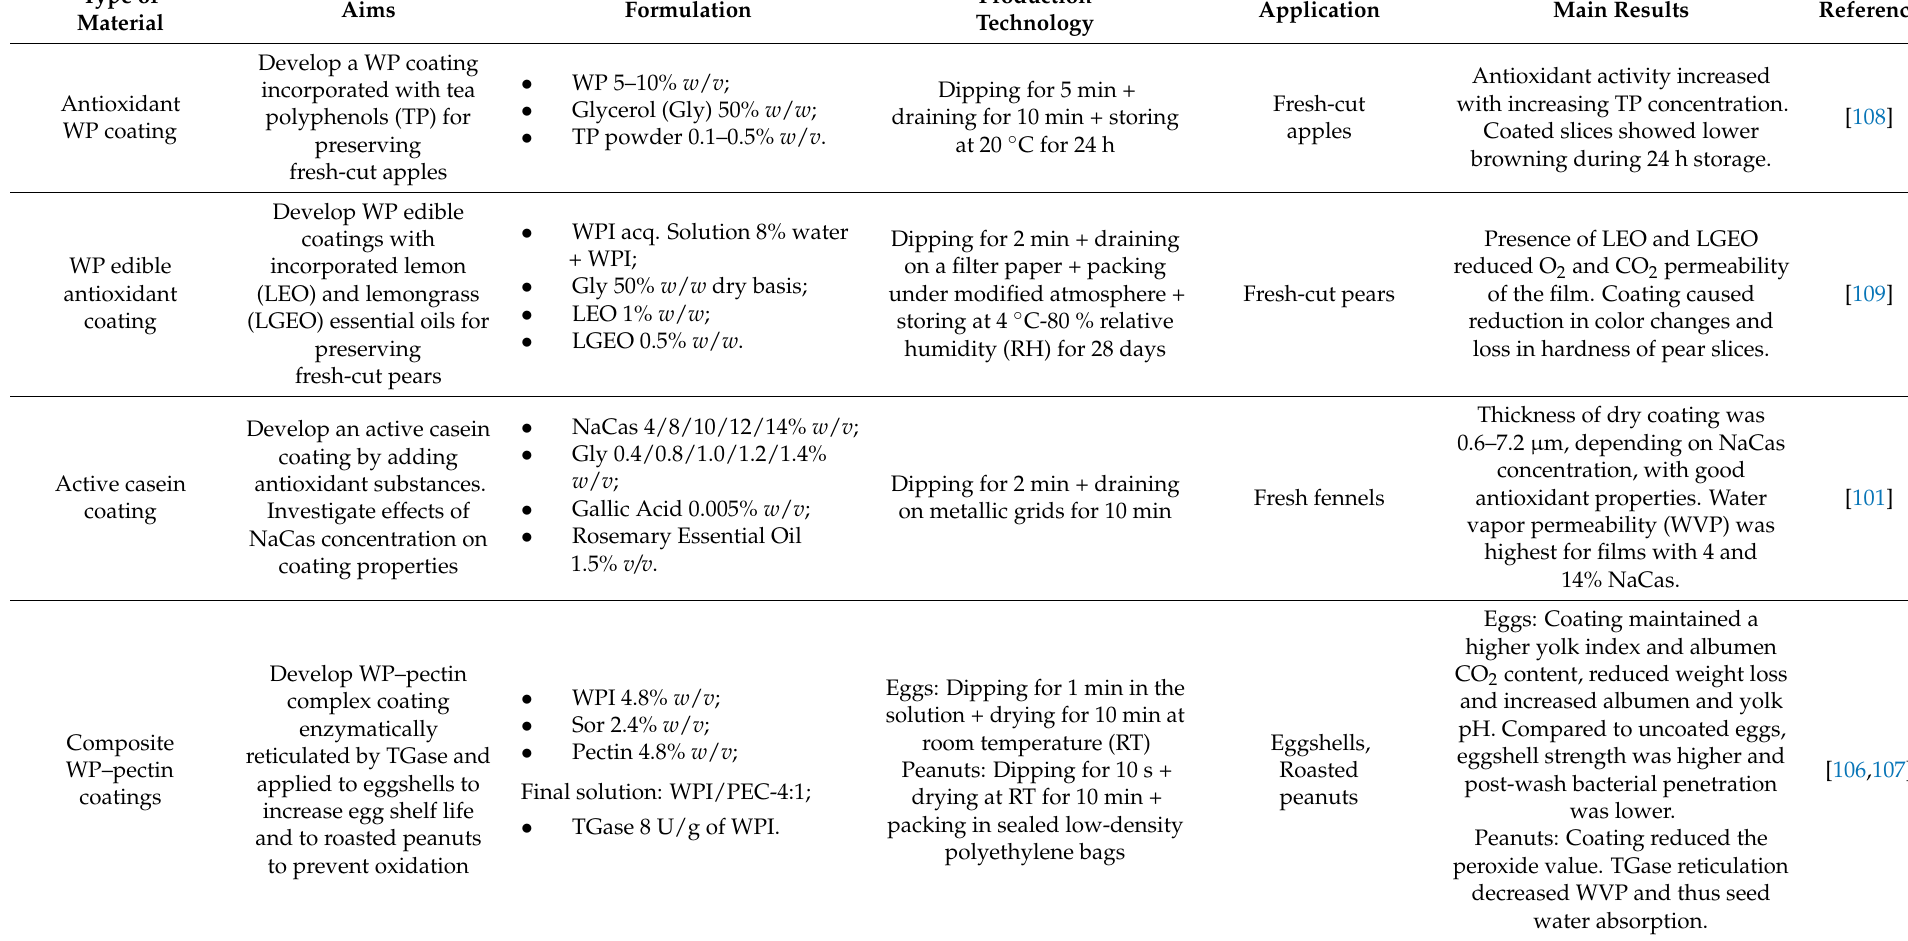
Table 3. Overview of the recent applications of milk-protein-based coatings in food